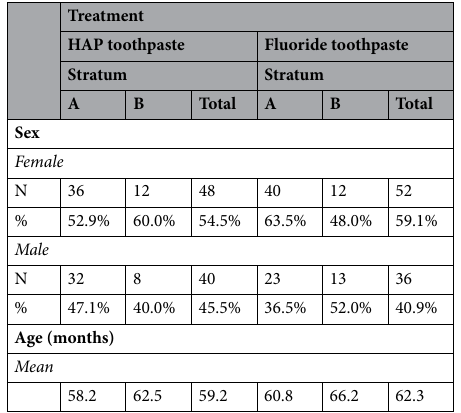
Table 1. Demographic data of the per protocol (PP)